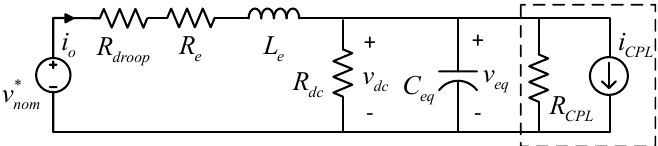
Figure 2. Simplified circuit diagram of the studied dc microgrid system.